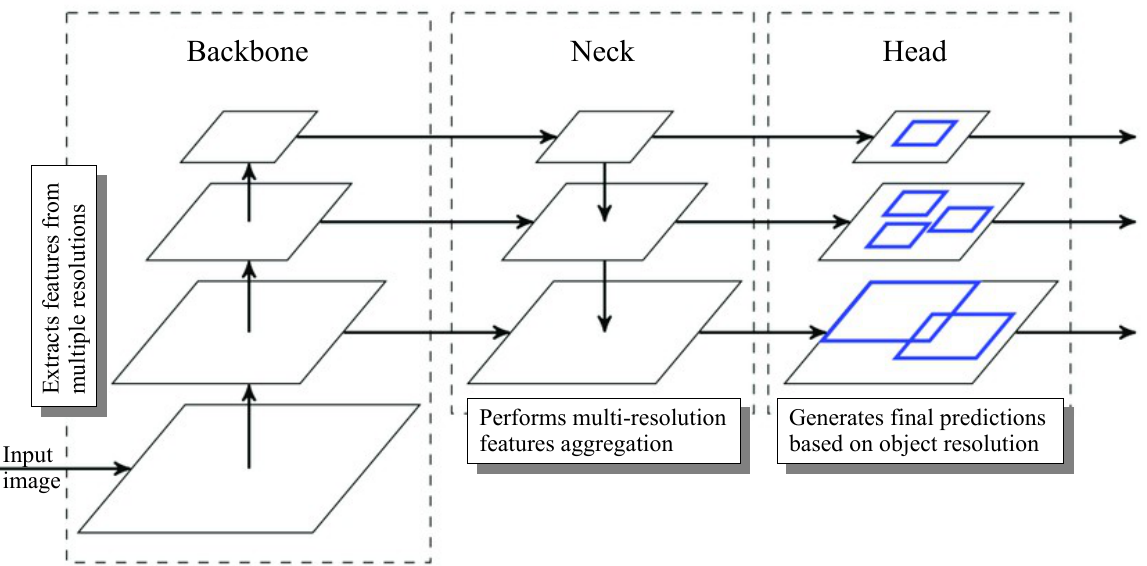
Figure 2. The generic YOLO model architecture, where the backbone extracts features from an image, the neck enhances feature maps by combining different scales, and the head provides bounding boxes for